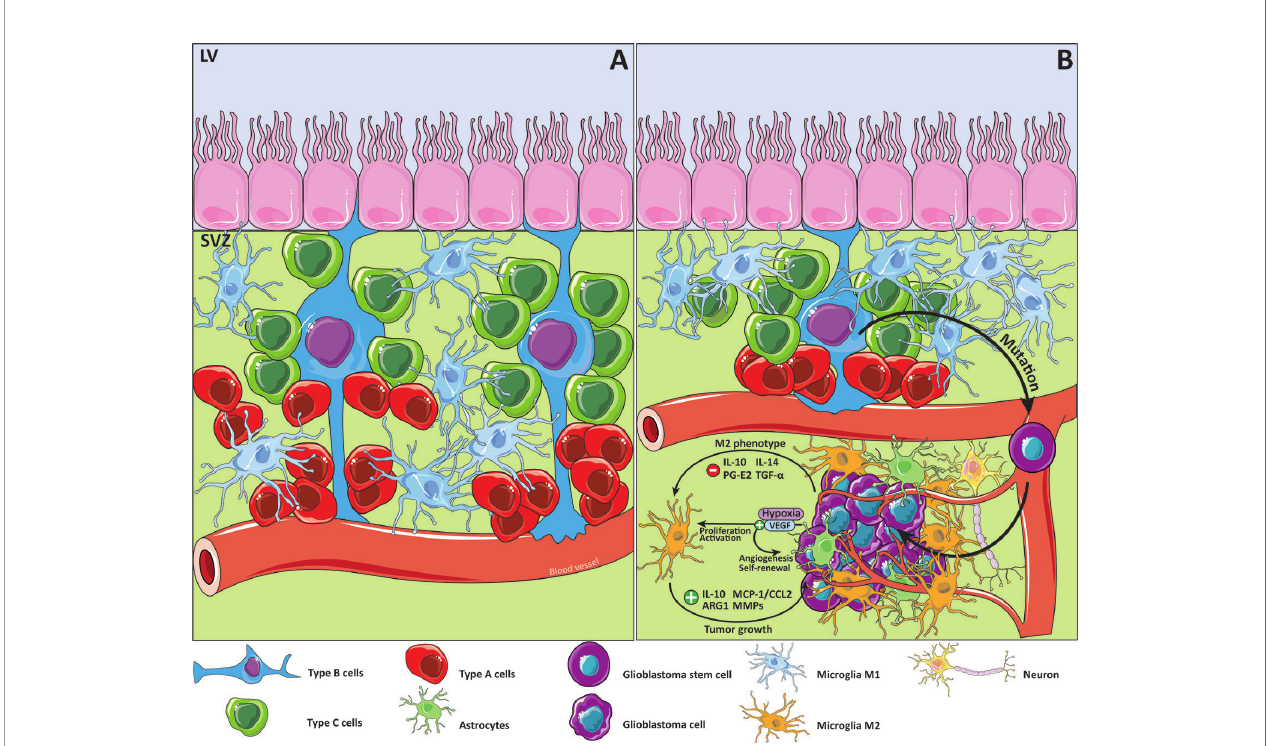
FIGURE 1 | Glioblastoma and the subventricular zone. Details of the subventricular zone (SVZ), microglia cells and its relationship with glioblastoma (GB). Type B cells, knowing as the resident neural stem cells (NSC) within the SVZ are postulated as an origin of glioblastoma stem cells (GSC) because of the accumulation of some mutations. Signaling pathways are modi fi ed in response of the changing cancer niche soluble factors that promote M2 microglial cells phenotype. (A) SVZ niche in physiological conditions. (B) SVZ niche in the GB